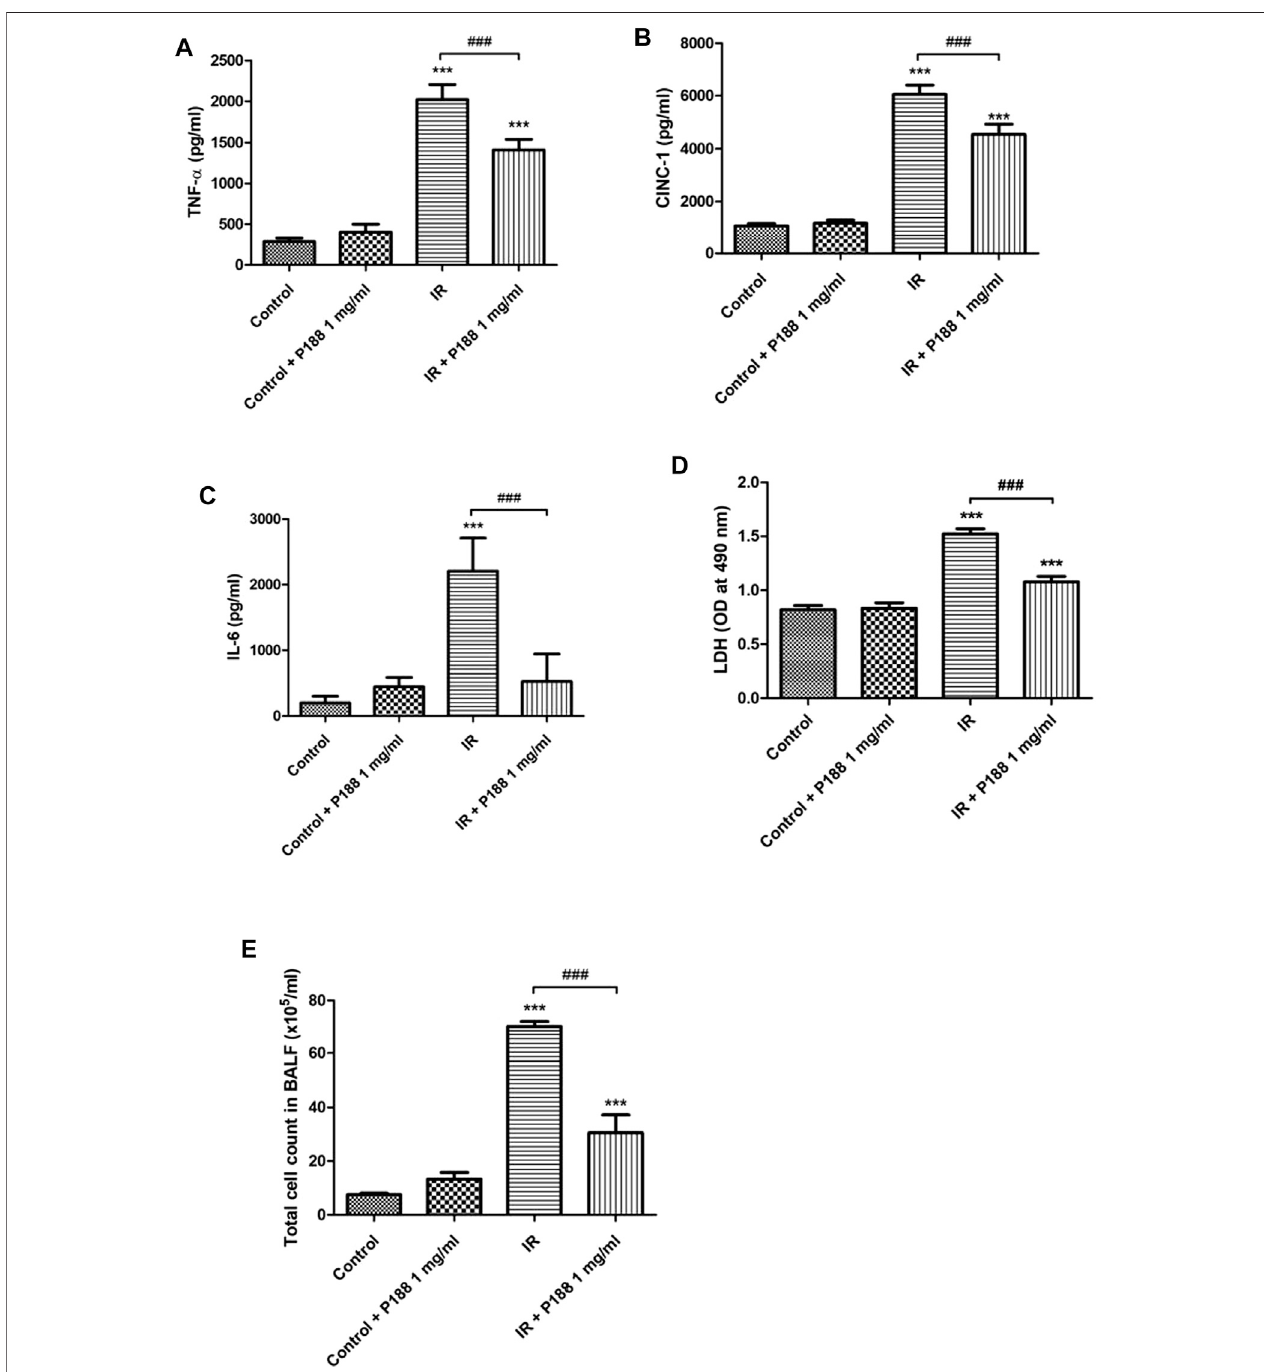
FIGURE2| EffectofP188onTNF- α ,IL-6,andCINC-1concentrations,LDHactivity,andtotalcellcountinBALF.ConcentrationsofTNF- α (A) ,CINC-1 (B) andIL-6 (C) , LDH activity (D) , and total cell count (E) were measured after 60 min reperfusion. Data are mean ± SD (6 rats per group); *** p < 0.001 compared with the control group; ### p < 0.001 compared with the IR group.